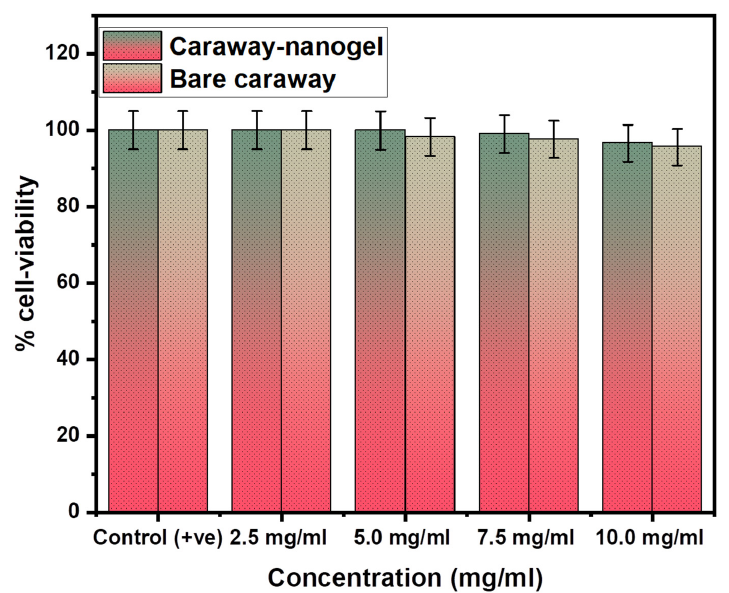
Figure 3. Percent cell-viability of bare caraway essential oil and caraway nanogel in HaCaT